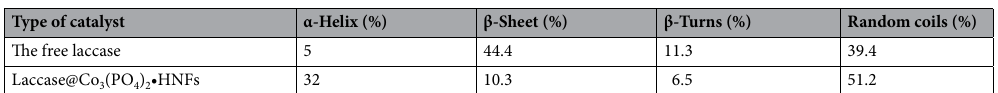
Type of catalyst α-Helix (%) β-Sheet (%) β-Turns (%) Random coils (%) The free